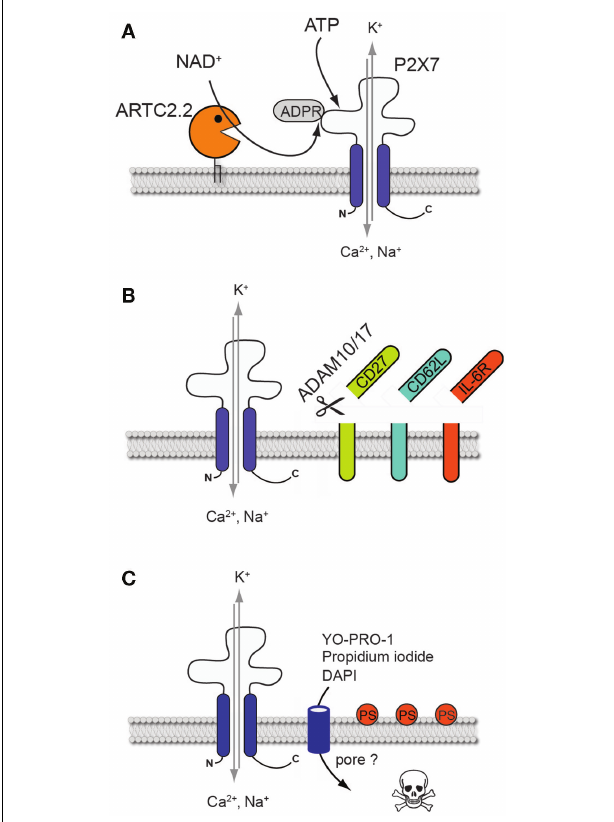
FIGURE 1 | Cellular consequences of P2X7 activation on mouse T cells . (A) Non-covalent binding of ATP or covalent ARTC2.2-mediated ADP-ribosylation results in P2X7 channel gating and in the influx of calcium and sodium ions and the efflux of potassium. (B) P2X7 activation triggers the activation of ADAM10 and ADAM17 that catalyze the shedding of the ectodomains of various cell surface proteins such as CD27, CD62L and IL-6R. (C) P2X7 activation leads to phosphatidylserine (PS) externalization, formation of a non-selective membrane pore allowing the uptake of fluorescent molecules such as DNA staining dyes, and ultimately to cell